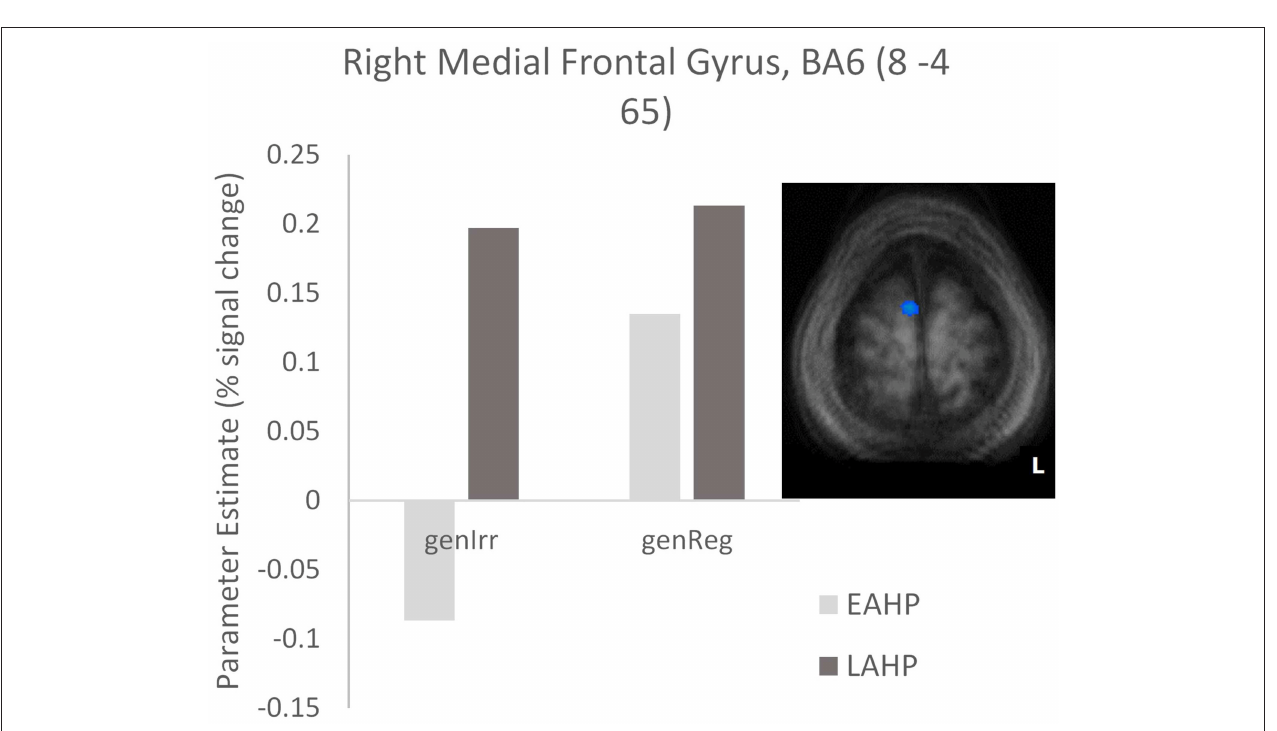
FIGURE 2 | Activation differences in BA6 between EAHP and LAHP bilinguals, during the generation of irregular past tense verbs (EAHP vs. LAHP). Activated regions are those activated above the indicated threshold ( p < 0.05, corrected).